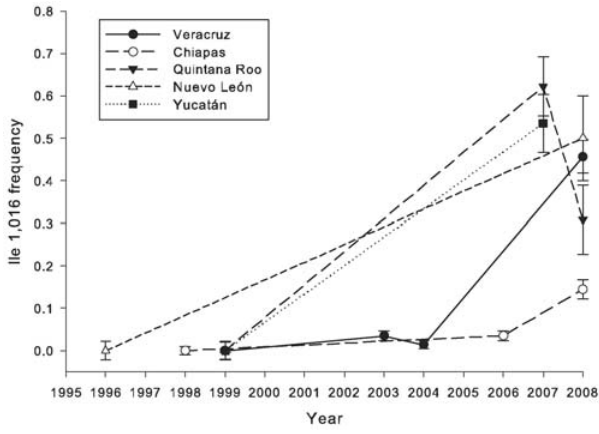
Figure 3. Overall frequency of Ile1,016 for Aedesaegypti by year in the states of Veracruz, Chiapas, Quintana Roo, Nuevo Leo´n, and Yucata´n.